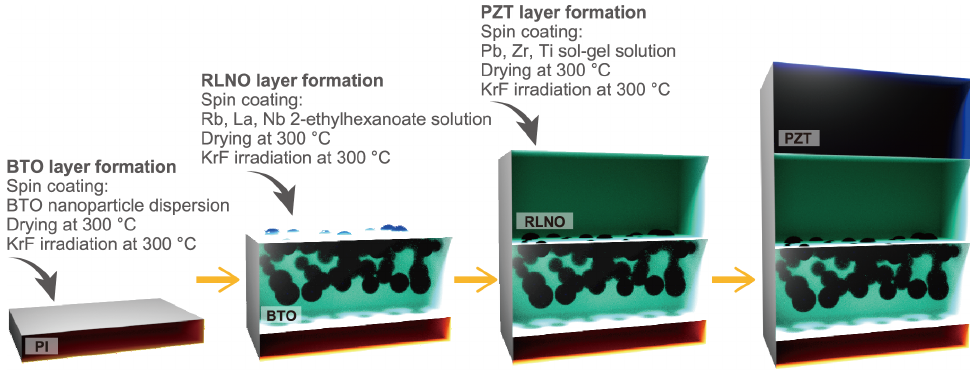
Figure 1. Flow chart of fabrication procedure for the PZT/RLNO/BTO/PI layer structure.